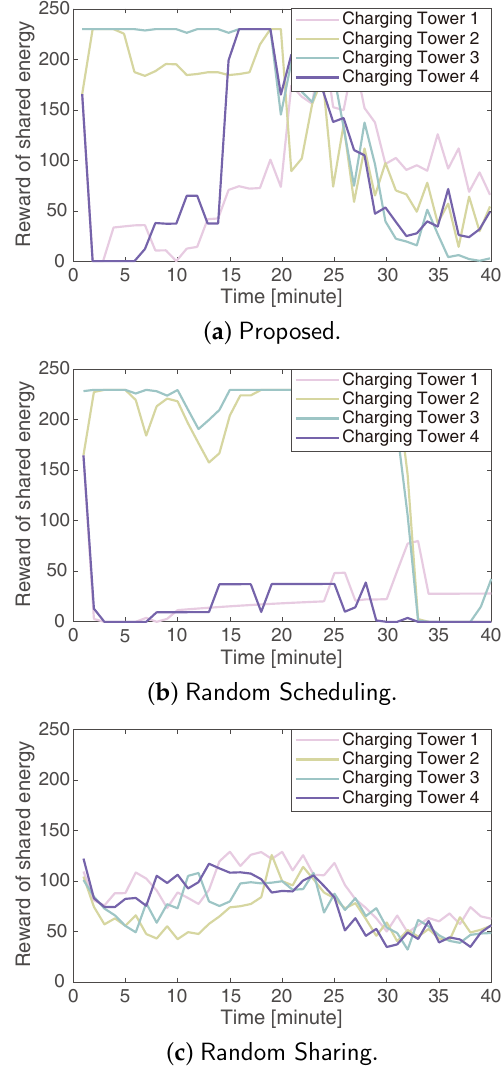
Figure 7. Shared energy among charging towers with ( a ) the Proposed algorithm, ( b ) the Random Scheduling algorithm, and ( c ) the Random Sharing